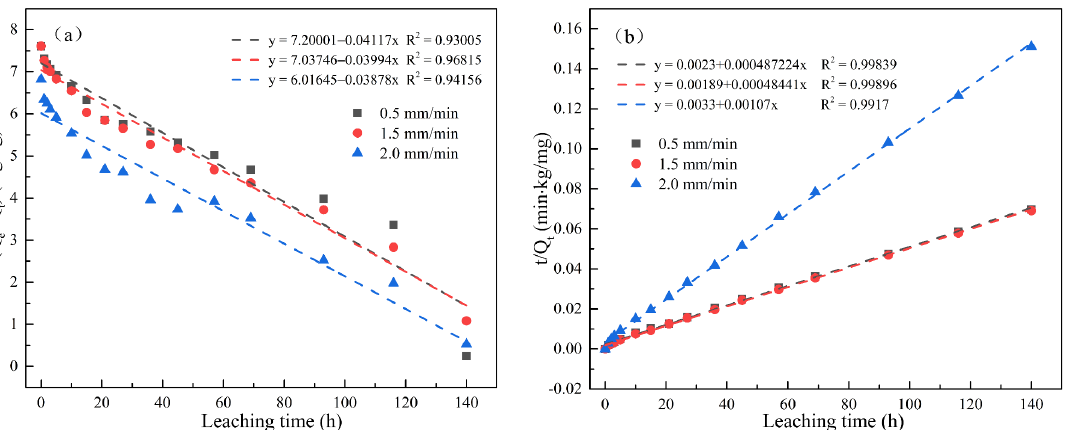
Figure 5. Linear regressions between ( a ) ln(Qe − Qt) and ( b ) t/Qt of the accumulation release amount for total cyanide.